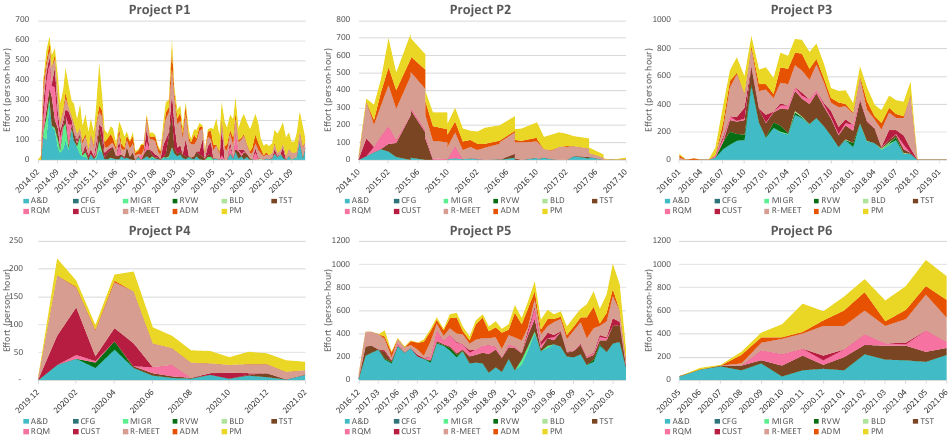
Figure 10. Work on recurring tasks in the researched